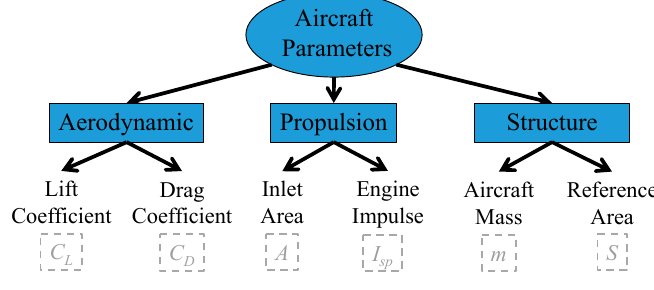
Figure 8. Considered parameters in this paper.